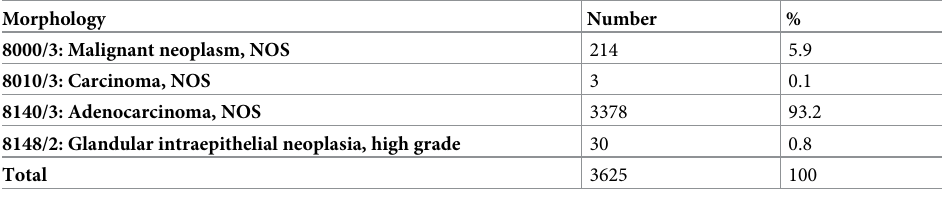
Table 1. Number and percentage of incident cases of prostate neoplasms by morphology, Cancer Registry, 1996– 2015.